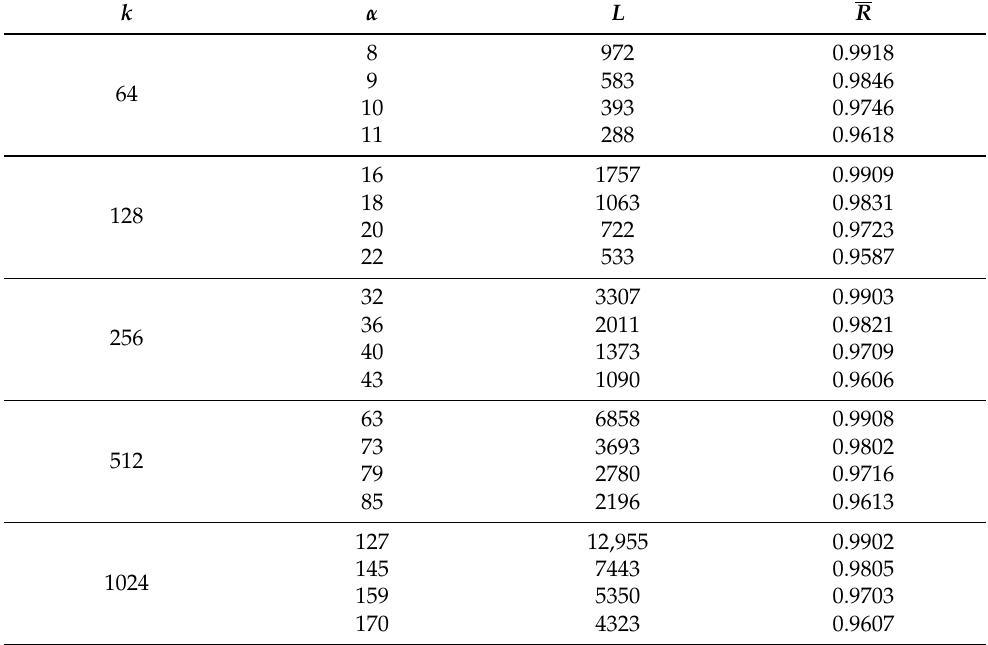
Table 1. Numerical examples of CWC